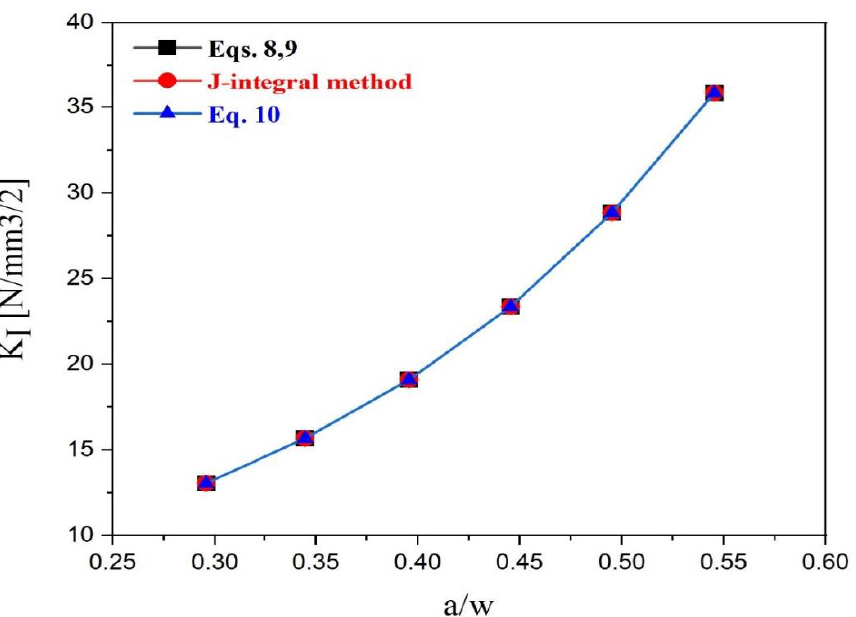
Figure 6. Relationship between KI and the initial crack length size a/w.